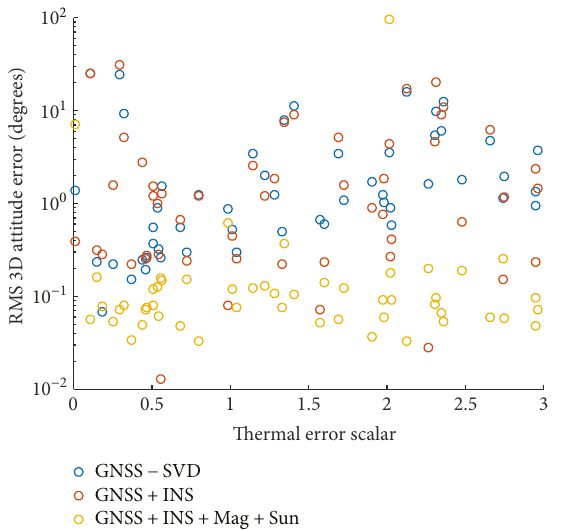
Figure 10: RMS attitude versus thermal error scale factor for each trial.